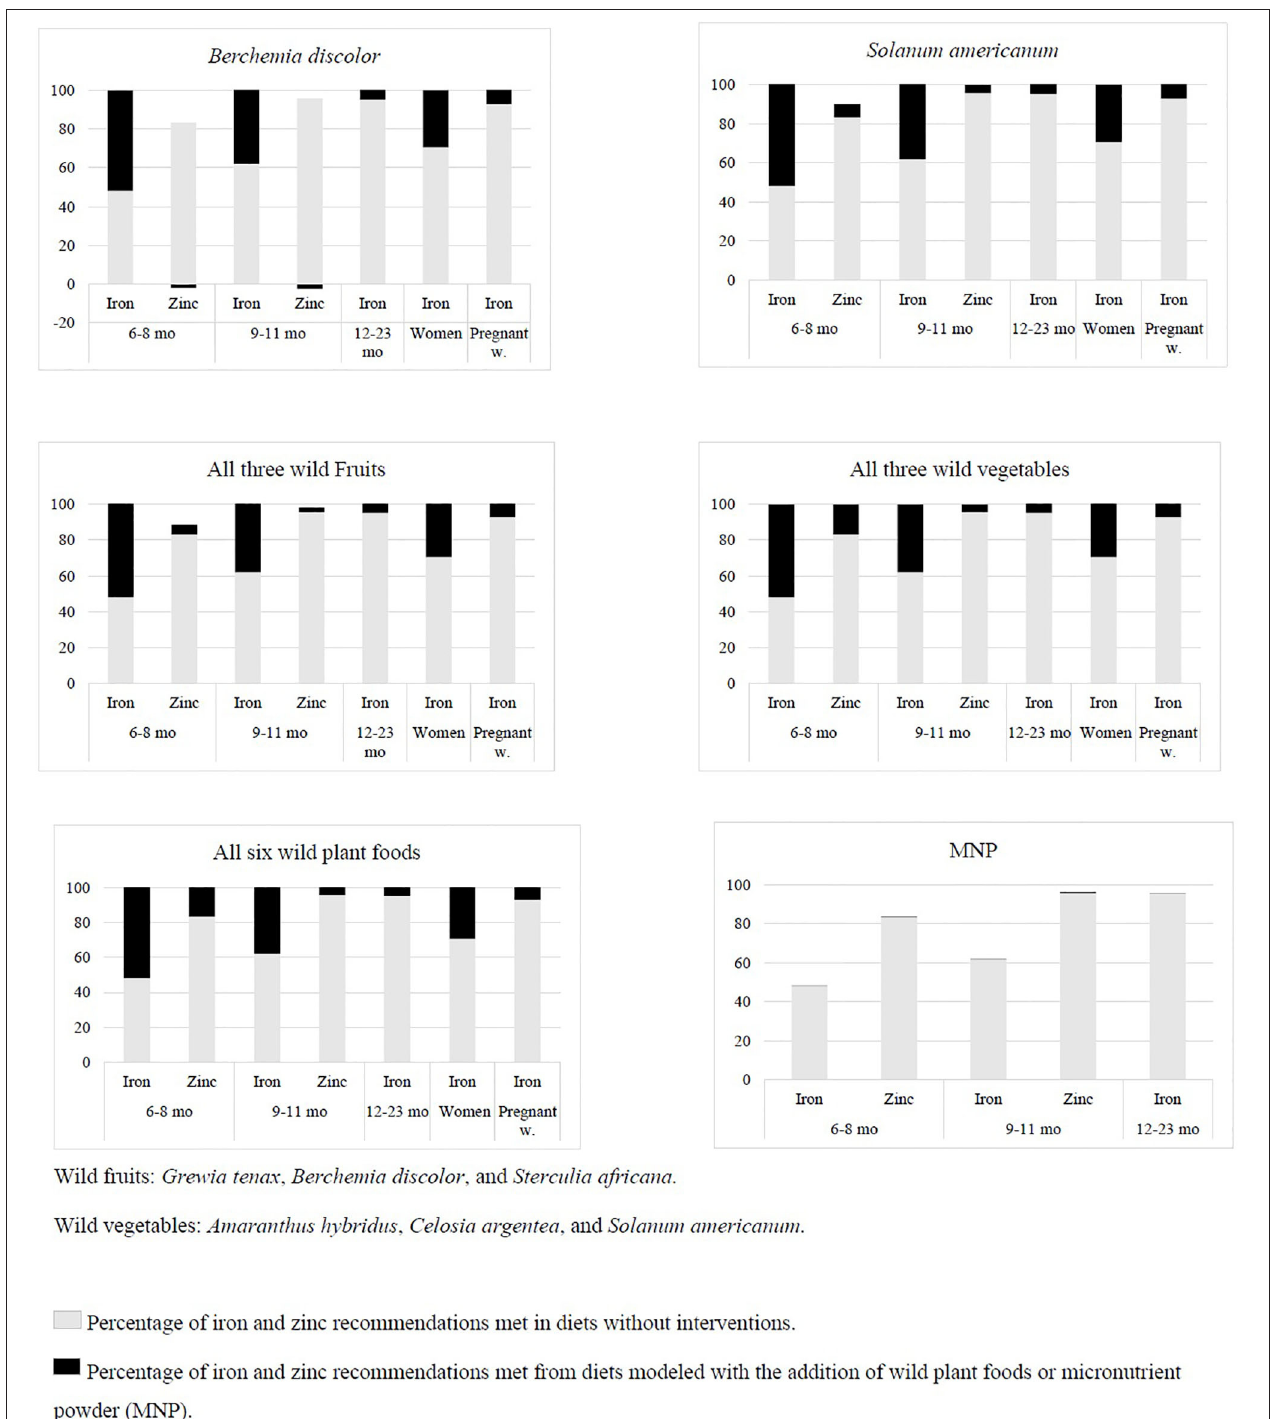
FIGURE 2 | Average percentage of iron and zinc recommendations met without and with wild plant foods and micronutrient powder for children between 6–8 months, 9–11 months, and 12–23 and non-pregnant/non-lactating and pregnant women throughout the year.